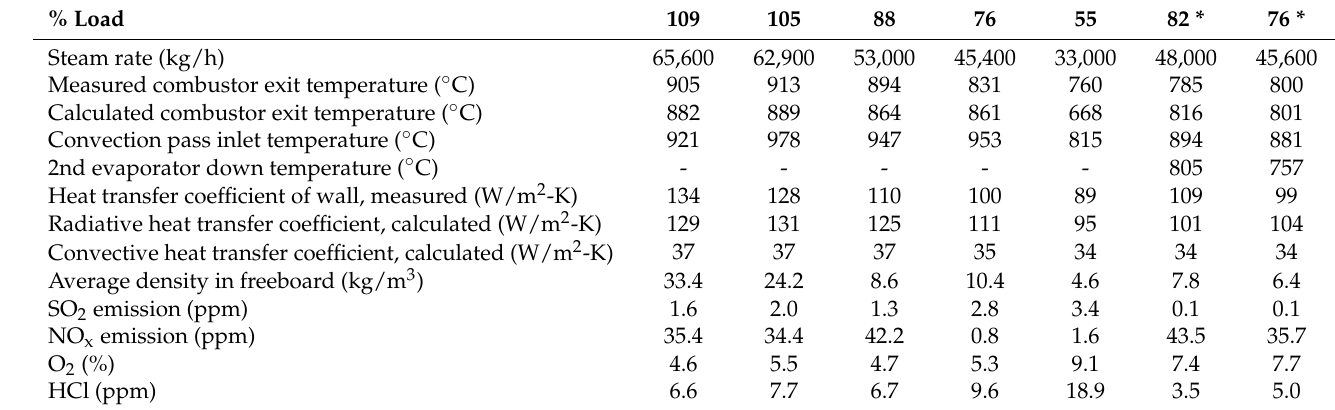
Table 3. Operation data of 60 ton/h CFBC